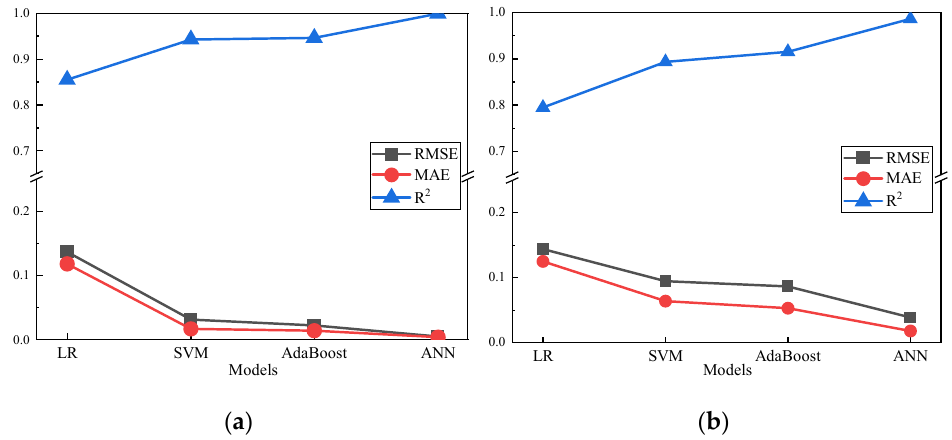
Figure 9. The prediction accuracy evaluation indexes of four comparison models: ( a ) results of the training stage; ( b ) results of the testing stage.